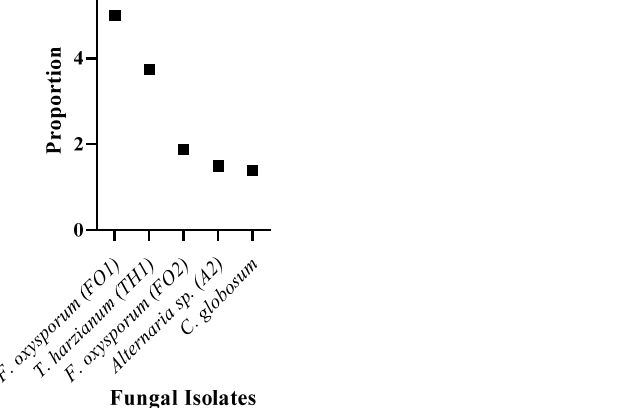
Figure 1. Proportion of fungal dry weight cultured in the media containing 15 mM cyanide.